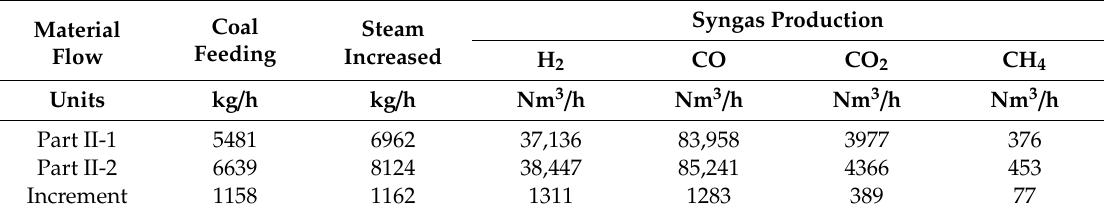
Figure 4. Variation of H 2 , CO, CO 2 , and CH 4 with coal input in the reductor: ( a ) H 2 ; ( b ) CO; ( c ) CO 2 ; ( d ) CH 4 . Table 6. The change of syngas production with coal feeding rate in the reductor.